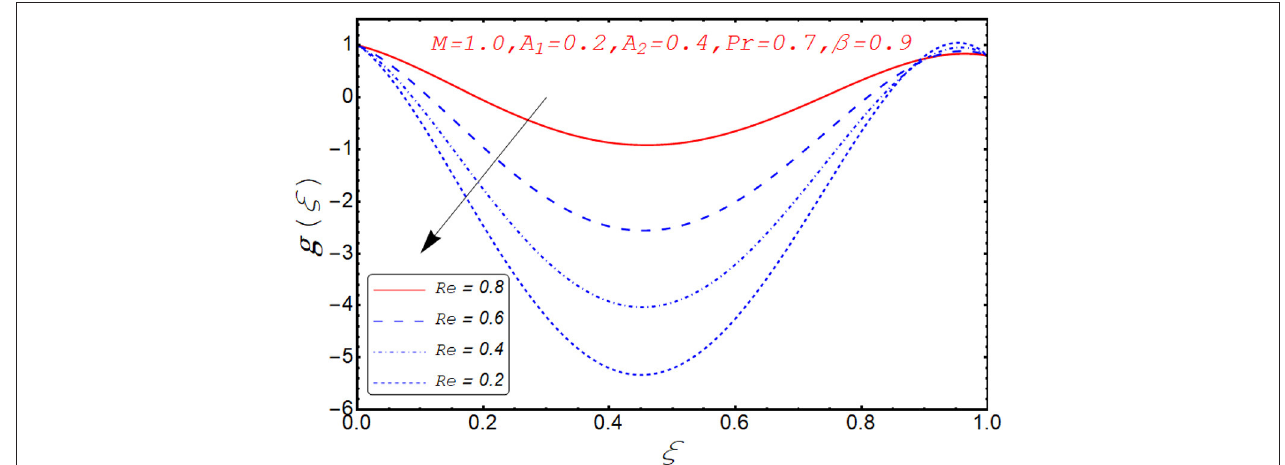
FIGURE 9 | Behavior of g ( ξ ) for different Re .